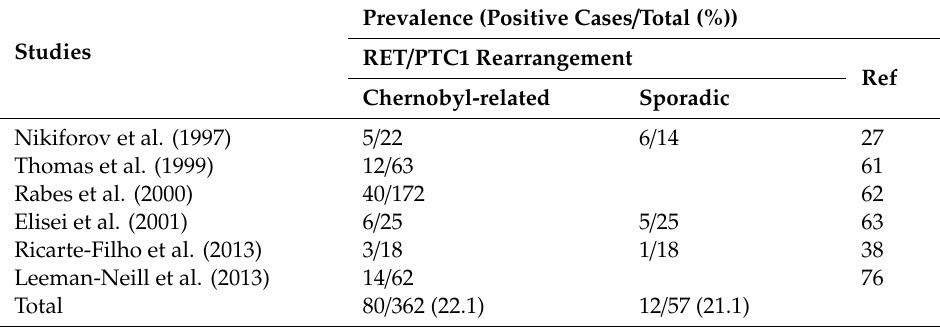
Table 2. Prevalence of oncogenic mutations in childhood papillary thyroid carcinomas.